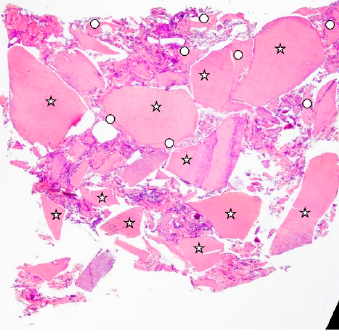
Figure 3. Histology extracted from Group 2 (dentin graft alone), With a circle for the bone and a star for the tooth graft. New bone was 4.12%, residual graft was 36.25%, and total calcified tissue was 43.49%. Table 1. Histomorphometric parameters of Group 1 (dentin graft + membrane) and Group 2 (dentin graft alone). Table 2. ISQ value at different times. No functional differences between the two groups (ISQ > 65 at 6 months from prosthesis load).